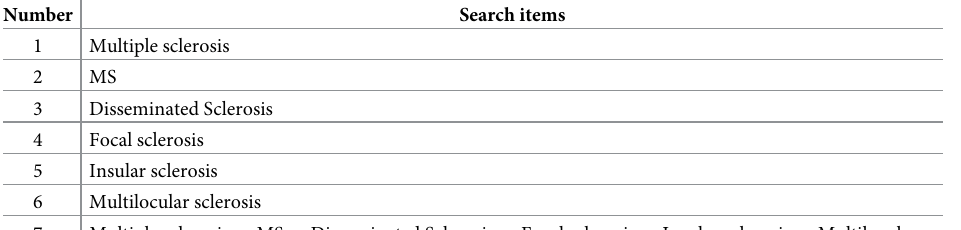
Table 1. Search strategy for the PubMed database.